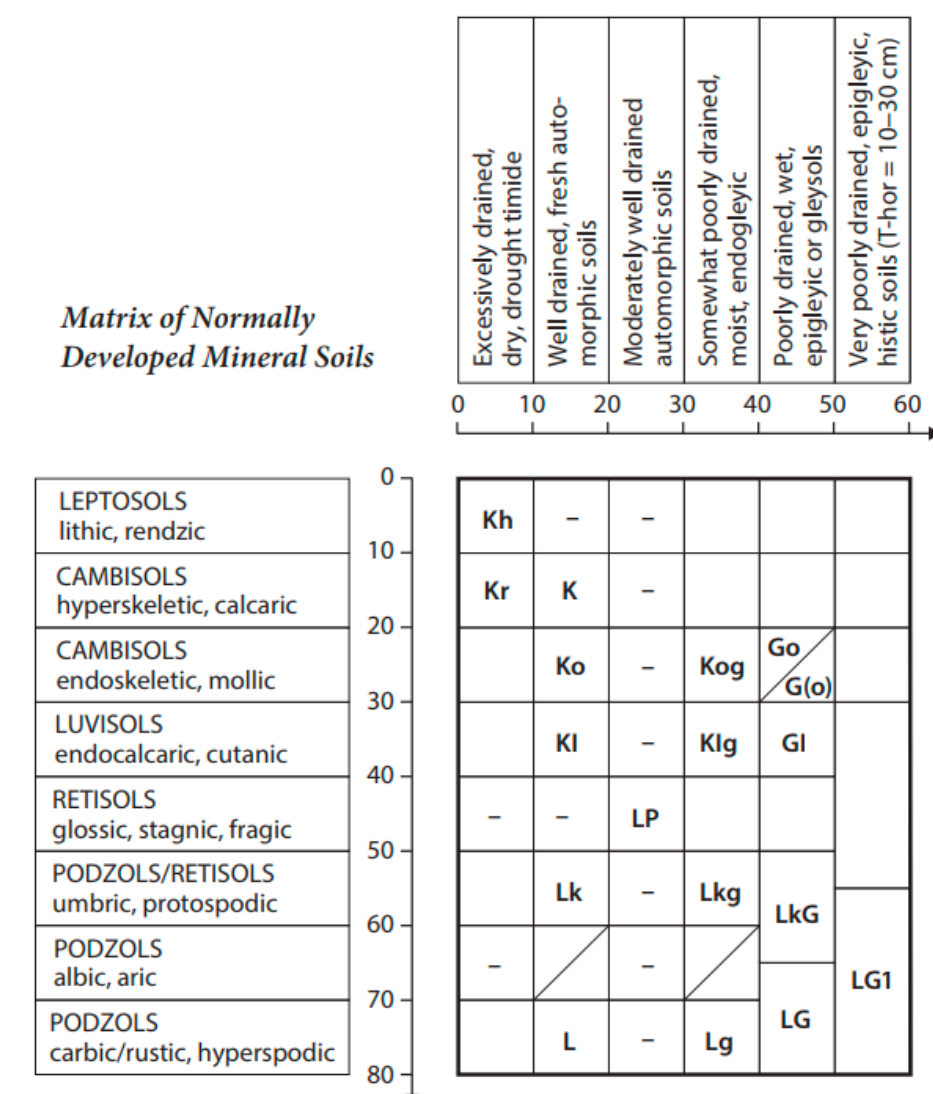
Figure 1. Estonian postlithogenic mineral soils and their correlation with WRB taxa. Soil codes and soil species names (in brackets are the soil names given by WRB): Kh— Limestone rendzinas (Rendzic Leptosols); Kr— Pebble - rich rendzinas (Calcari-Skeletic Regosols); K— Pebble rendzinas (Calcaric Cam- bisols); Ko— Leached or typical brown soils (Mollic Cambisols); Kog— Gleyed typical brown soils (Gleyic Cambisols); KI— Eluviated (brown) soils (Cutanic Luvisols); KIg— Gleyed eluvial soils (Gleyic Luvisols) ; LP— Pseudopodzolic soils (Glossic Retisols); Lk— Sod-podzolic soils (Umbric Podzols); Lkg— Gleyed sod- podzolic soils (Gleyic Umbric Podzols); L— Typical Podzols (Haplic Podzols); Lg— Gleyed Podzols (Gleyic Haplic Podzols); Go— Leached gley-soils (Mollic Gleysols); G(o)— Saturated gley-soils (Calcic Gleysols); GI— Eluviated gley-soils (Dystric Gleysols); LkG— Sod-podzolic gley-soils (Umbric Gleysols); LG— Gley-Podzols (Epigleyic Podzols); LG1— Peaty Podzols (Fibrihistic Podzols).